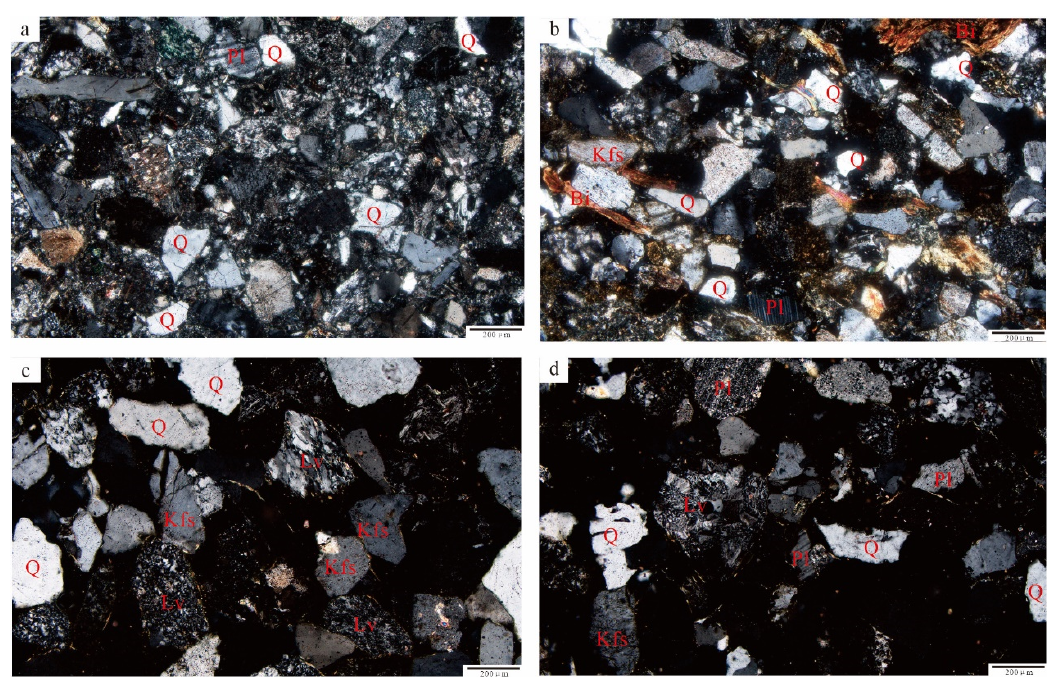
Figure 4. Micrographs of sandstones in northern Songliao Basin. ( a – d ) Grey sandstone of the Sifangtai Formation Q—Quartz, Pl—plagioclase, Kfs—potassium feldspar, Bi—Biotite, Lv—Debris.